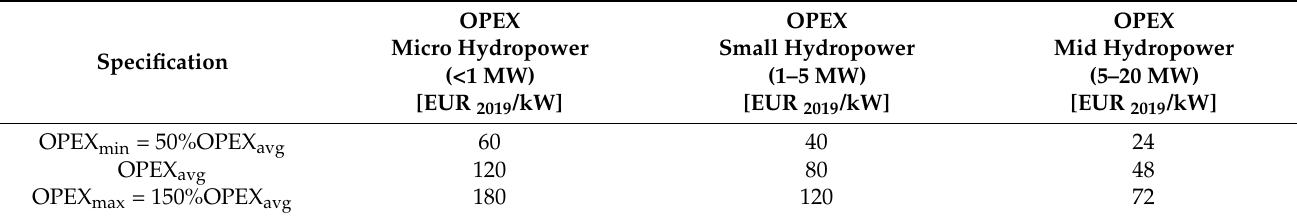
Table 5. Unit operational expenditures OPEX used in the